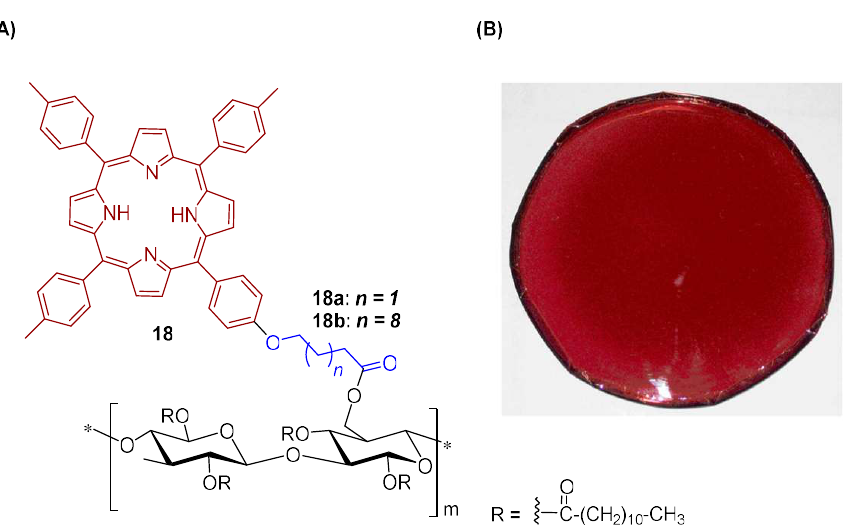
Figure 14. ( A ) Structure of tri-tolyl porphyrin derivative immobilized in ester laureate cellulosic polymer hybrid material ( 18a and 18b ) prepared by Krausz and co-workers (adapted from reference [156]). ( B ) Porphyrinic cellulose laurate ester plastic. Reprinted with permission from Ref. [156]. 2008, Elsevier.